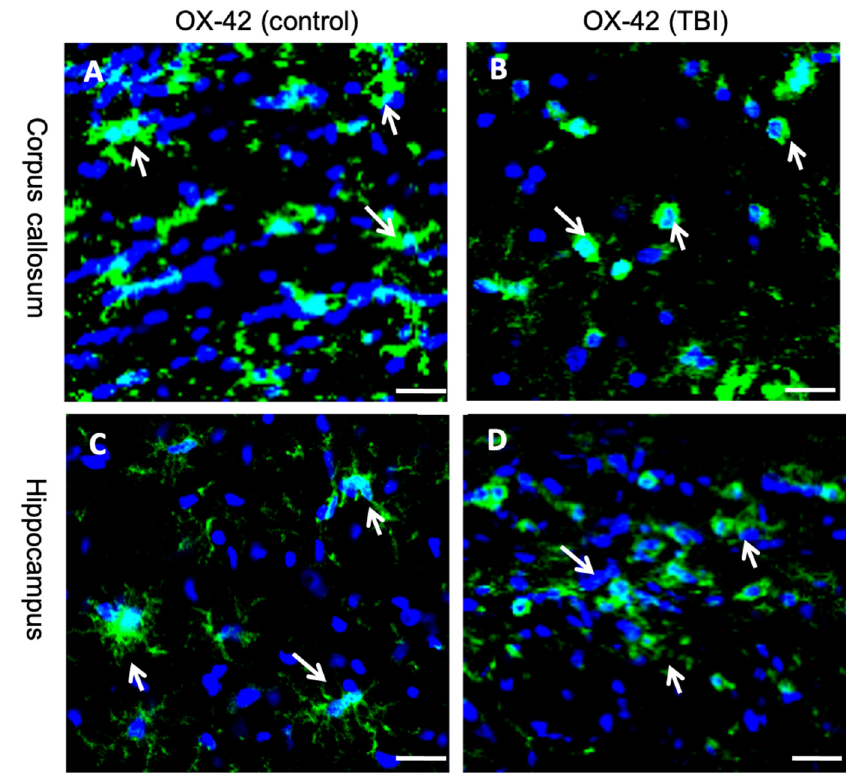
Figure 5. Immunohistochemistry data for corpus callosum (( A )—control, ( B )—TBI) and Hippocampus (( C )—control, ( D )—TBI); Scale bar: 20µm